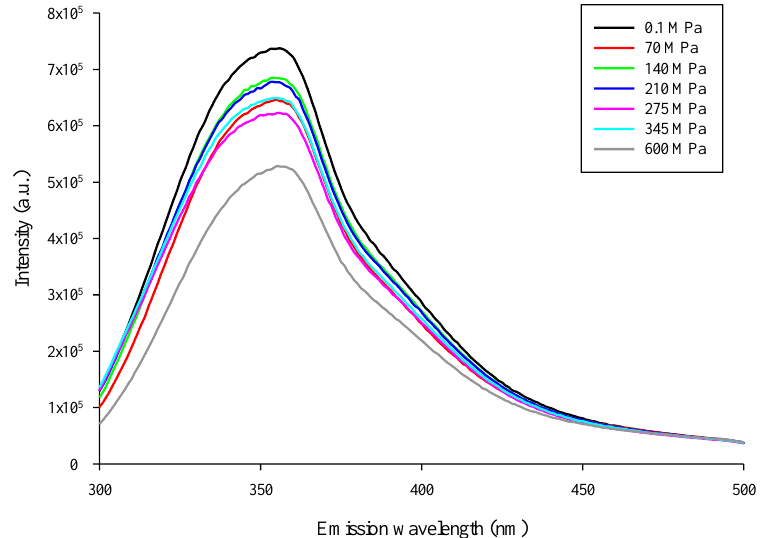
Figure 4. Intrinsic fluorescence spectra of control (0.1 MPa) and pressure-treated (70 to 600 MPa) mealworm protein solutions.